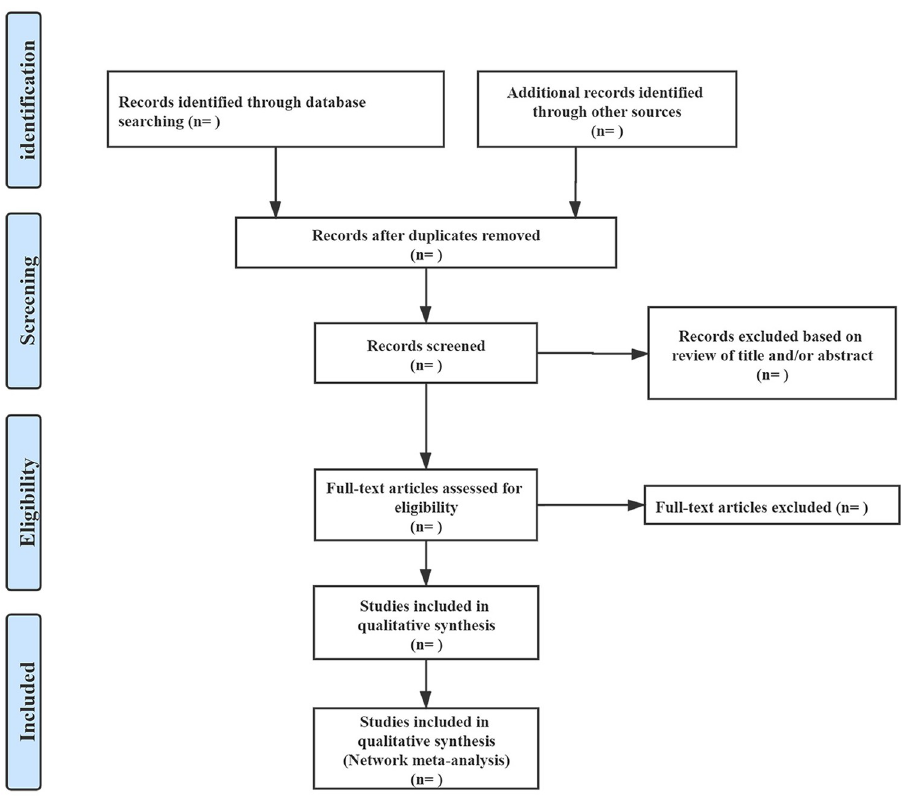
Fig 1. Summary of evidence search and